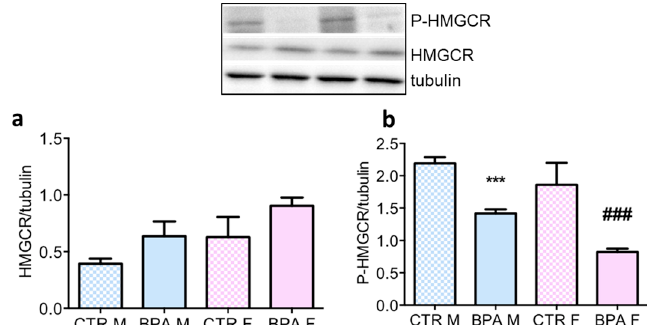
Figure 3. HMGCR total and phosphorylation levels in the brain of rat fetuses in utero exposed to 2.5 µg/kg/day of BPA. Representative western blot and densitometric analysis of total HMGCR ( a ) and P-HMGCR ( b ). n = 6 for each experimental group. Tubulin served as housekeeping protein to normalize protein loading. Statistical analysis was carried out by using two-way ANOVA followed by Bonferroni post-hoc test. *** = p < 0.001 vs. CTR M; ### = p < 0.001 vs. CTR F.